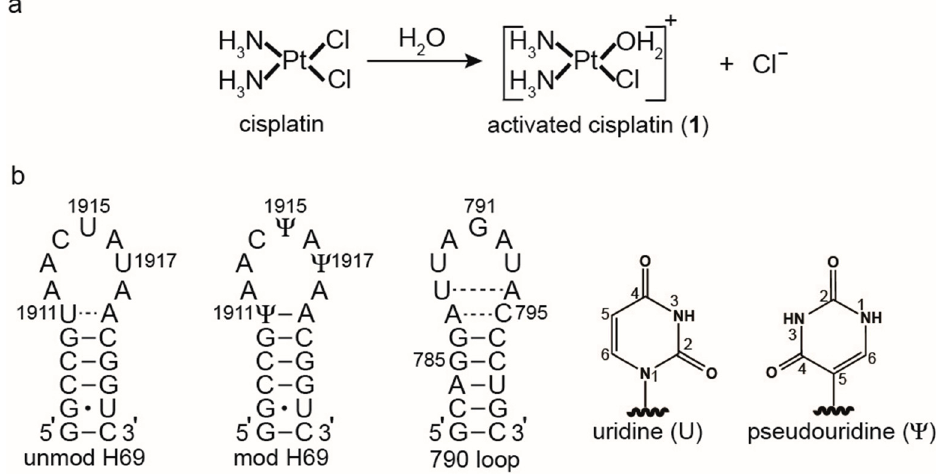
Figure 1. Cisplatin and model rRNA constructs. ( a ) Cis -diamminedichloridoplatinum(II) forms cis -diammine(aqua)chloridoplatinum(II), 1 , in water by displacement of a chlorido ligand; ( b ) Three RNA constructs were used: unmodified H69 with uridines at 1911, 1915, and 1917 ( E. coli numbering); modified H69 containing pseudouridine ( Ψ ) at the same positions; and the 790 loop. The 790 loop contains an additional G-C base pair (782–800). The base structure of Ψ is compared to